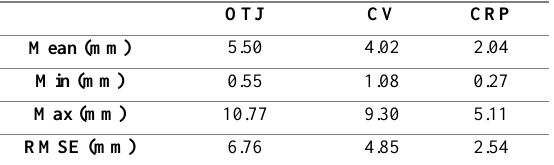
Table 8: Distance error on Check_Field_3.